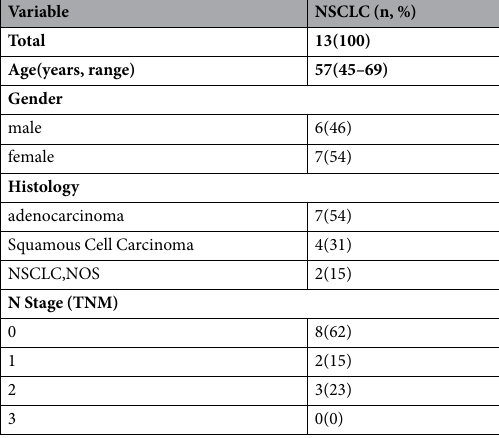
Table 6. Patients information and diagnosis (n = 13). NSCLC, non-small cell lung cancer; AC, adenocarcinoma; SCC, squamous cell carcinoma; NOS, not otherwise